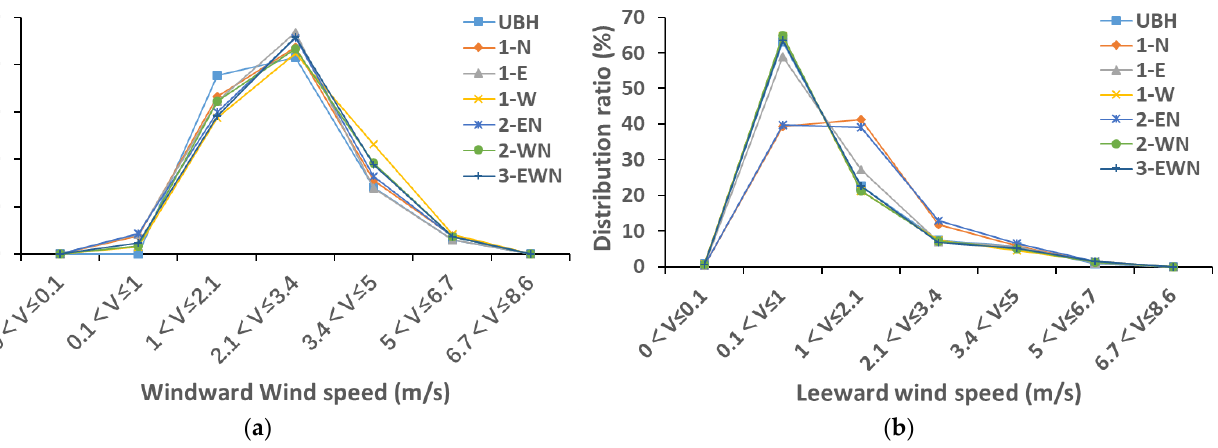
Figure 7. Proportional distribution of air velocity for seven building distribution patterns. ( a ) Wind- ward side of the building and ( b ) leeward side of the building. Table 4. Air velocity proportions for seven building distribution patterns.